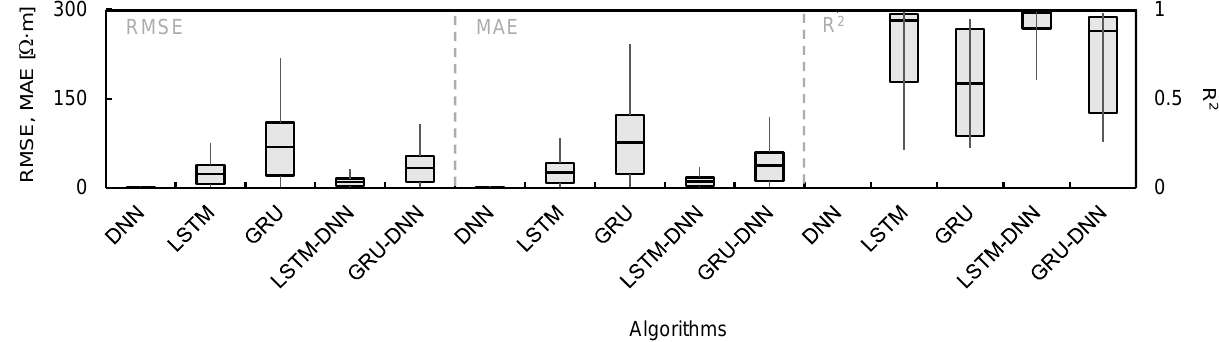
Figure 8. Box plots of DNN, LSTM, GRU, LSTM-DNN, and GRU-DNN between the measured and predicted electrical resistivity.